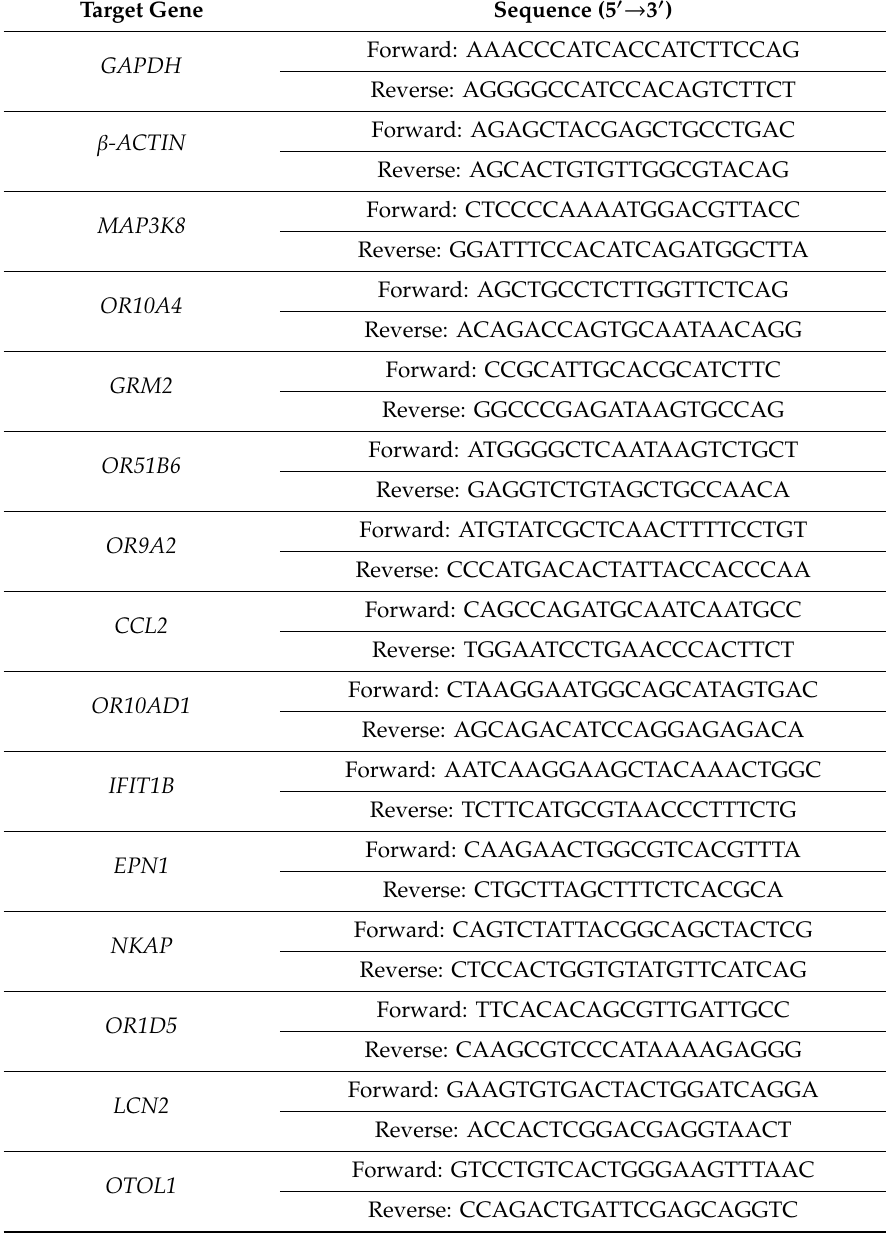
Table 2. Primer sequences used for the amplification of the target genes in RT